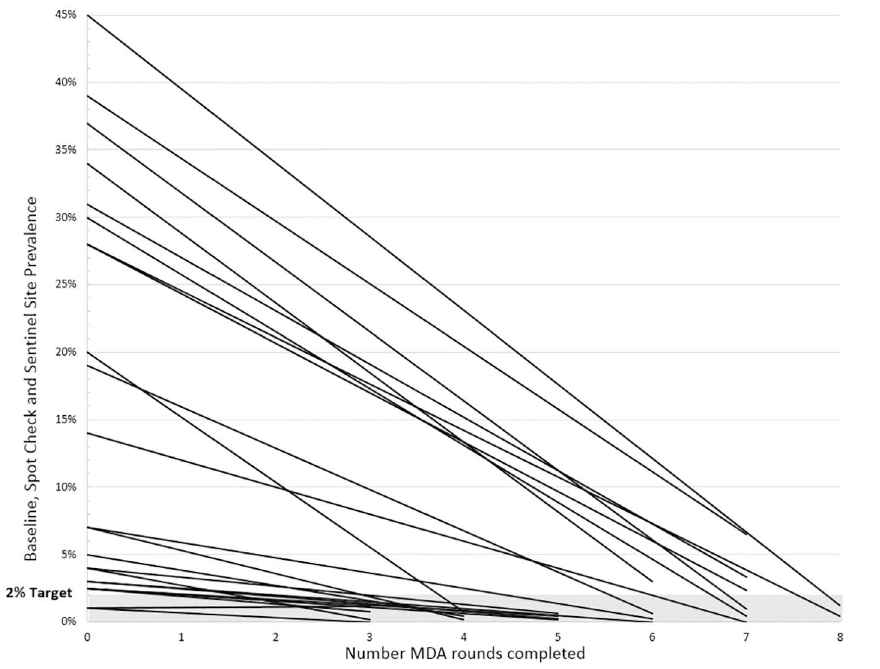
Fig 4. Decline in LF antigen level from start of program until 2014.